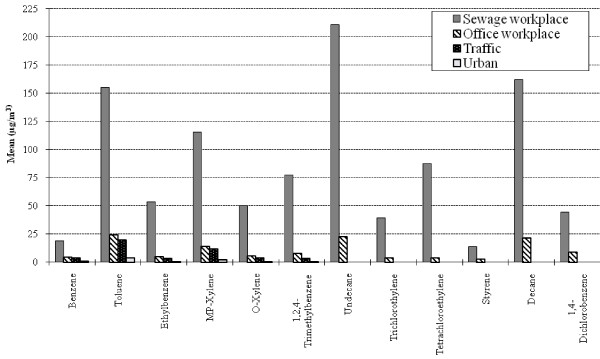
Volatile organic compounds (VOCs) concentration patterns in the workplaces air and from the nearest outdoor monitoring stations. Statistically significant higher means concentrations (P < 0.01) among sewage workers compared to all other groups for all substances. Comparison of workplace and ambient air concentrations is incomplete because some VOCs measured in the workplaces are not measured by traffic or background urban monitors (undecane, trichloroethylene, tetrachloroethylene, styrene, decane and 1,4-dichlorobenzene).